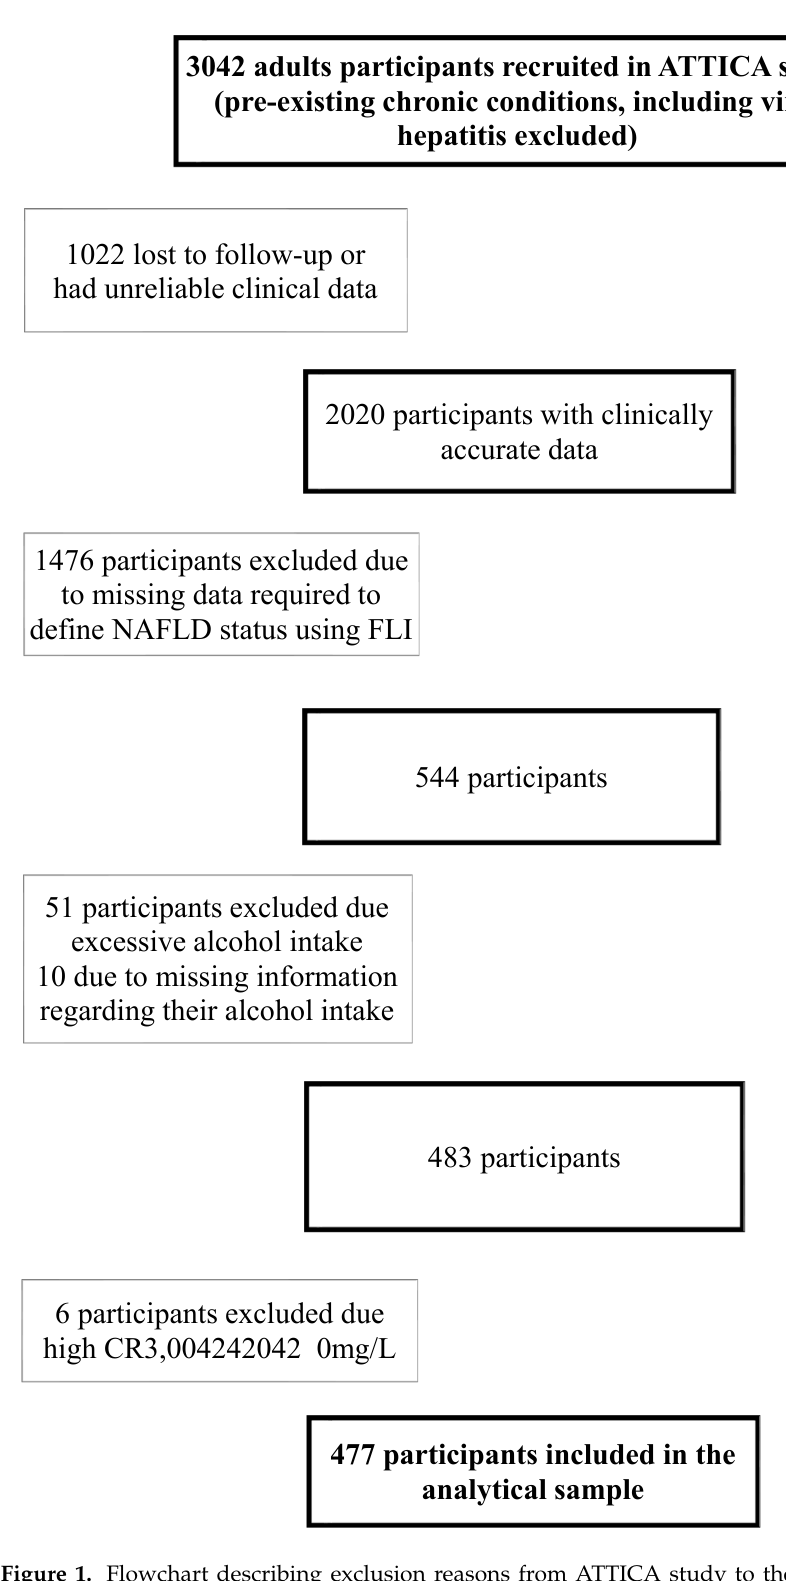
Figure 1. Flowchart describing exclusion reasons from ATTICA study to the analytical sample. NAFLD: Non-alcoholic fatty liver disease; CRP: C-Reactive Protein.